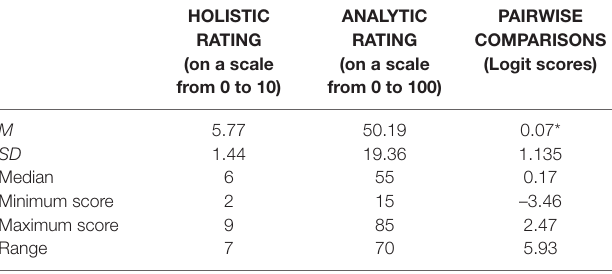
TABLE 9 | Descriptive statistics of the assigned scores using the rating